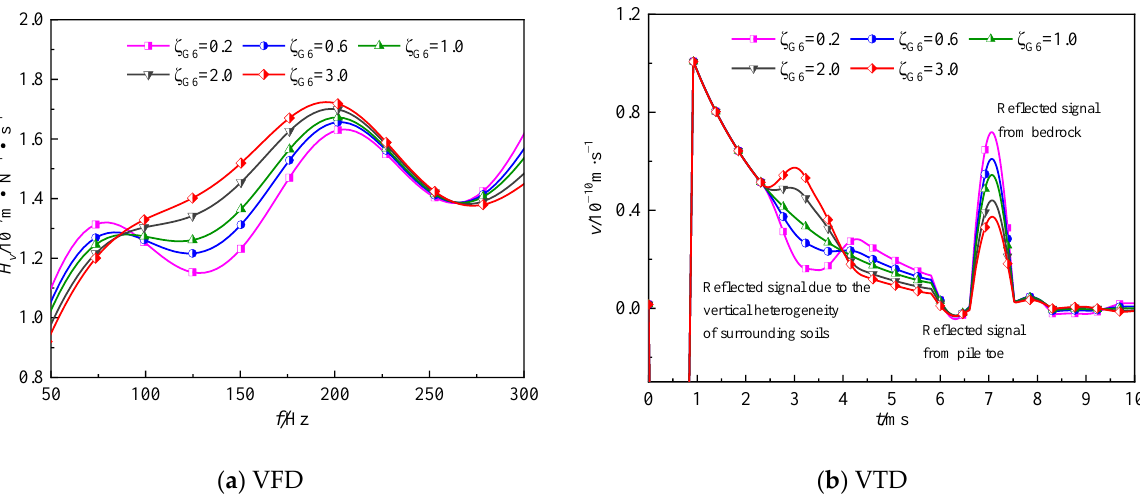
Figure 7. Influence of the vertical heterogeneity of surrounding soils on the vertical vibration velocity.